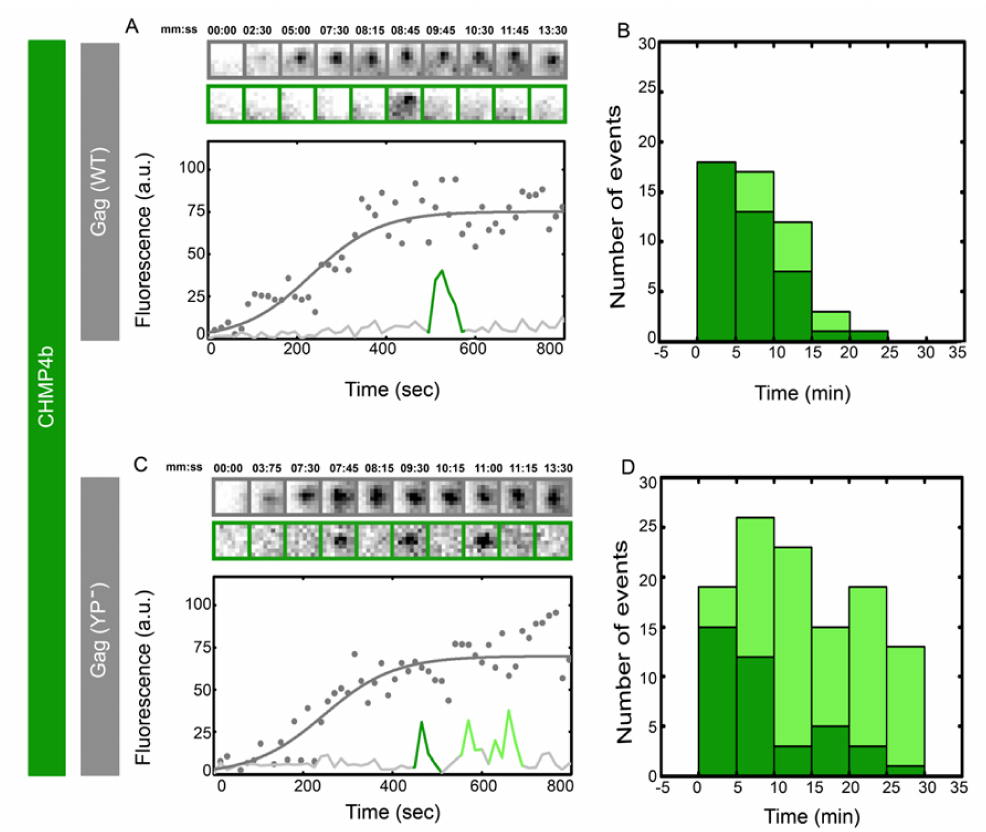
Figure 2. Single versus multiple transient recruitments of CHMP4 into HIV Gag VLPs versus HIV Gag (YP-) VLPs. HeLa cells were transfected with 900 ng of ∆ CMV–eGFP–flex–CHMP4b and 600 ng (total 1500 ng plasmids) of Gag–mCherry ( A , B ) or Gag (YP-)–mCherry ( C , D ) and imaged 7 h after transfection. Assemblies of individual representative VLPs are shown with intensity plots (as gray dots and fitted with gray line) and cropped TIRF images of the Gag (top, gray) and CHMP4b (bottom, green) for ( A ) Gag–mCherry VLPs and ( C ) Gag (YP-)–mCherry VLPs. Histograms of the first time (dark green) and later recruitments (light Green) of CHMP4b are shown for ( B ) Gag–mCherry VLPs and ( C ) Gag (YP-)–mCherry VLPs. The majority of the first CHMP4b recruitment was within 1–10 min after the VLP assembly completed during both YP- and WT